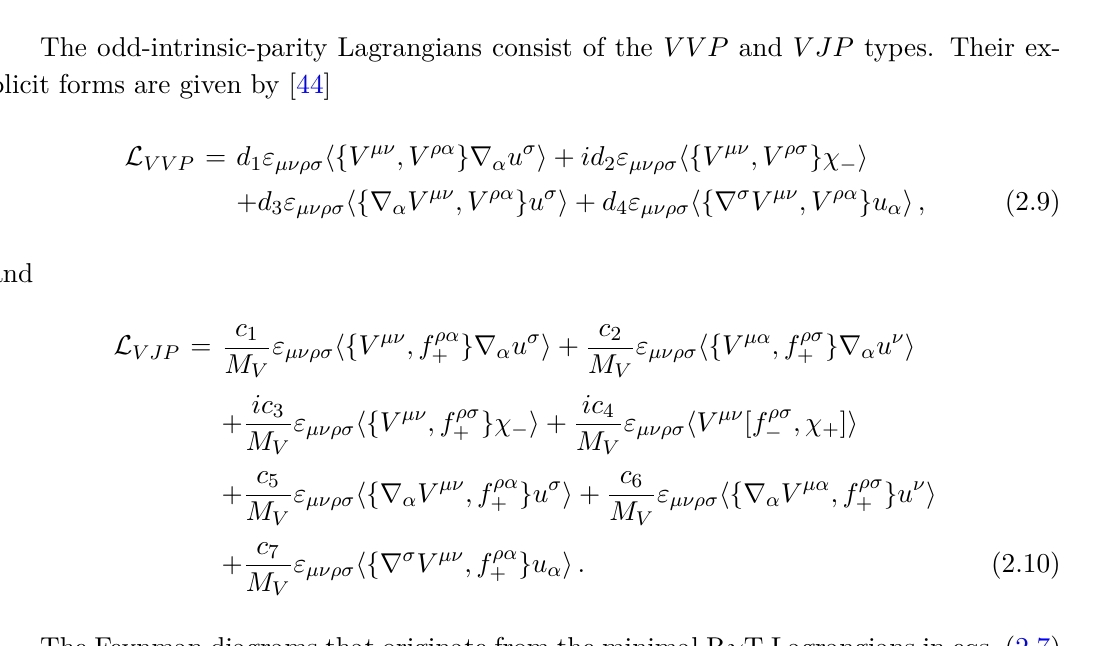
Figure 2 . Feynman diagrams contributing to the vector form factors from the resonance chiral Lagrangians in eqs. (2.9) and